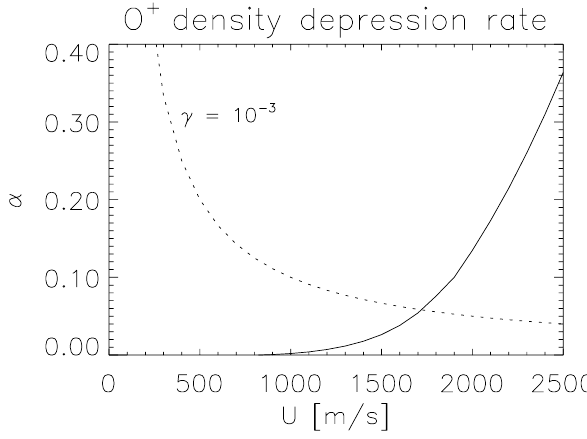
Fig. 5. Density depression rate (solid line) and the threshold of the GDI growth rate (dotted line) as a function of the plasma flow